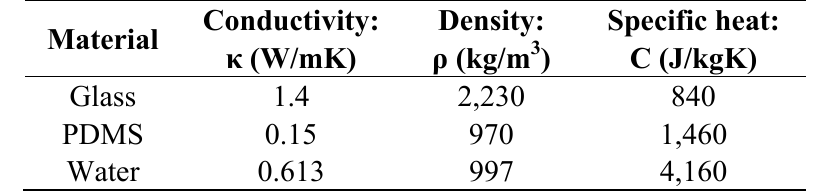
Table 1. Material properties of glass, PDMS and water under the conditions of temperature: 298 K and pressure: 1